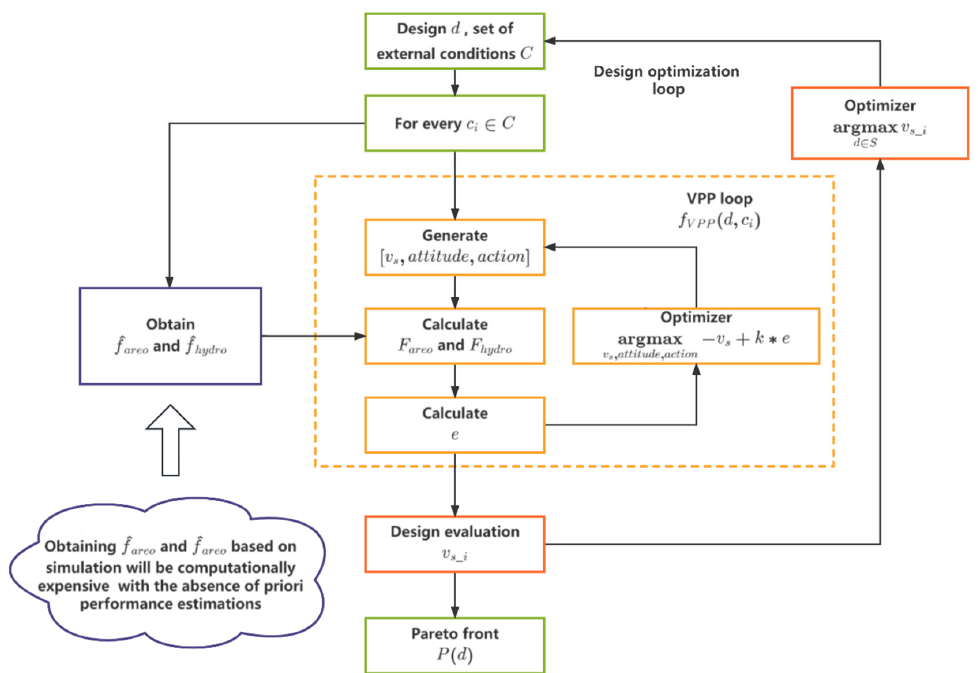
Figure 3. Problem Description. The core issue is the difficulty of obtaining surrogates of a particular design’s hydro- and aerodynamic characteristics in the absence of prior performance estimates. Note: The same colouring scheme is used as in Figure 1 for comparison.